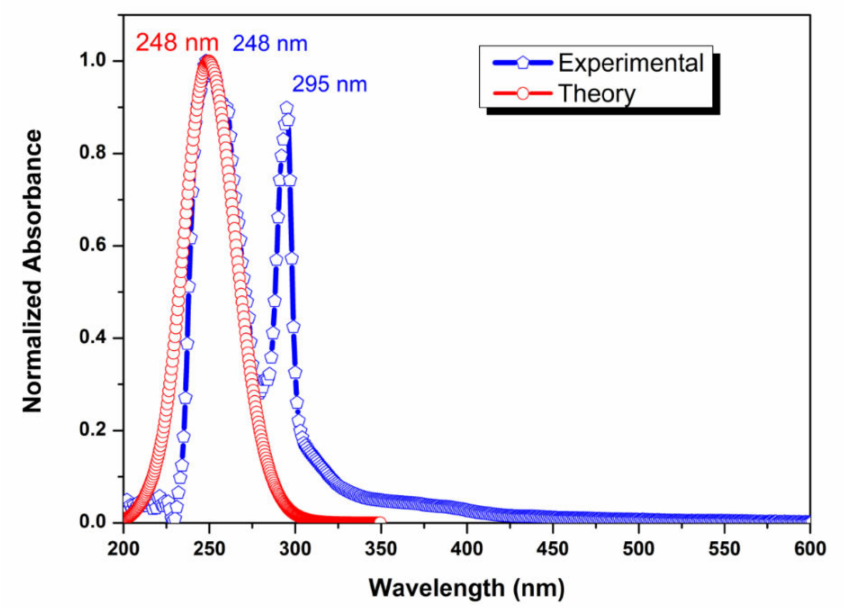
Figure 8. UV-Vis spectra of the title